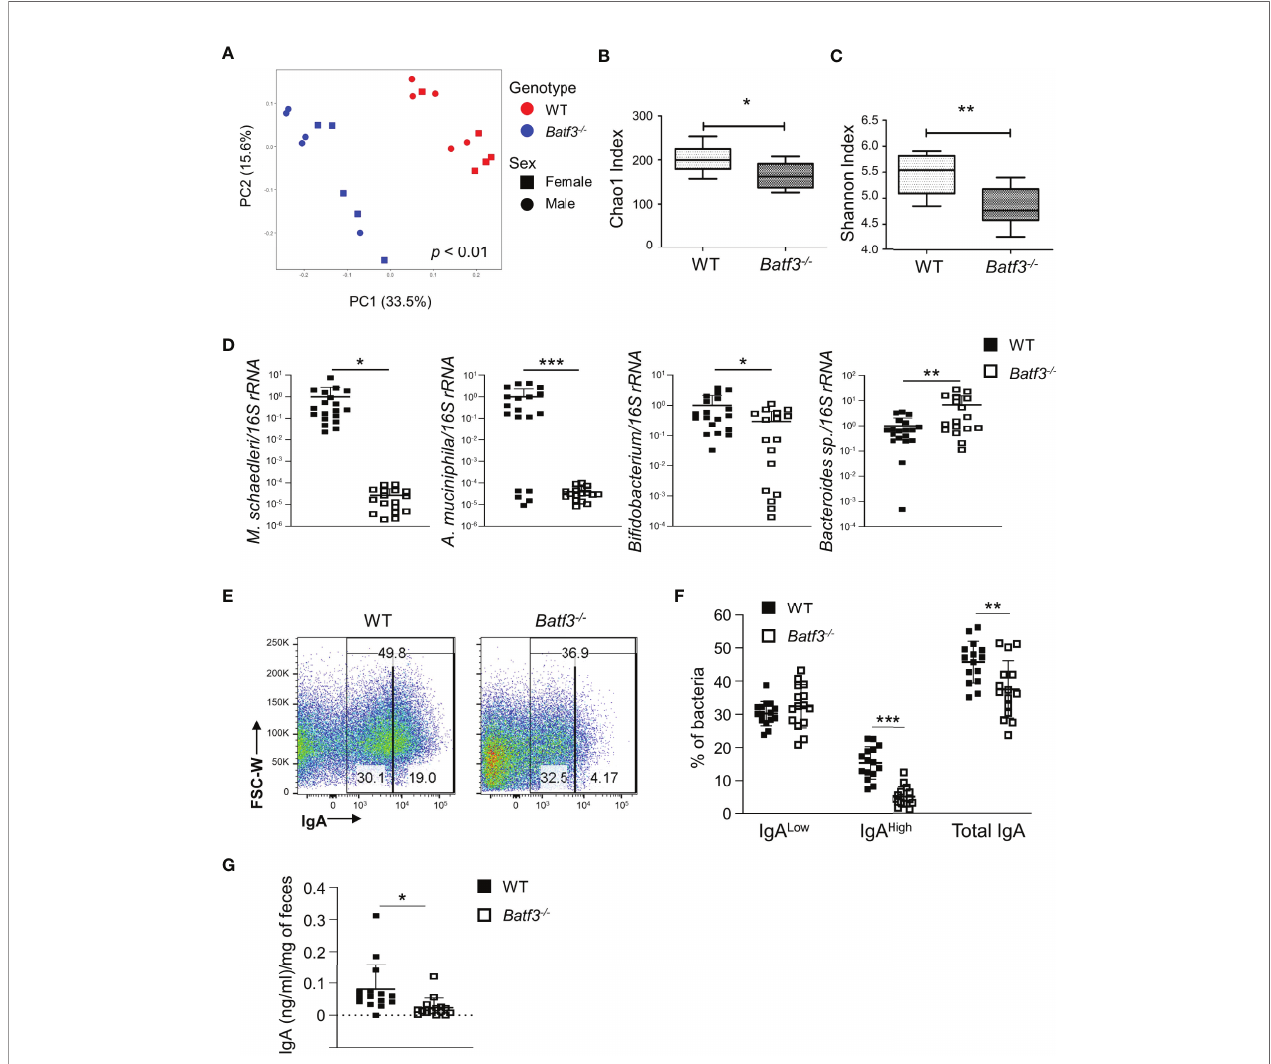
FIGURE 6 | BATF3-de fi ciency leads to intestinal dysbiosis preceding the development of metabolic syndrome. (A) Principal Coordinates Analysis (PCoA) of fecal microbiota of 8-week-old WT and Batf3 -/- mice fed standard chow with consideration for genotype and sex of mice (n = 10/genotype). (B, C) Chao1 index (B) and Shannon index (C) of fecal microbiota of 8-week-old WT and Batf3 -/- mice (n = 10/genotype). (D) Quanti fi cation of relative abundance of Mucispirillum schaedleri, Akkermansia muciniphila, Bi fi dobacterium , Bacteroides sp. in fecal samples of 8-week-old WT and Batf3 -/- mice by qPCR (n = 17-19/genotype). (E) Representative fl ow cytometry plots of IgA coated fecal bacteria isolated from WT and Batf3 -/- mice. (F) Quanti fi cation of IgA low , IgA high and total IgA coated bacteria in feces of WT and Batf3 -/- mice at 8 weeks of age (n =15/genotype). (G) Secreted IgA from fecal samples of WT and Batf3 -/- mice at 8 weeks of age measured by ELISA (n = 15/ genotype). Data are represented as means ± SD (A, D, F, G) or median (bar), interquartile range (box), and range (whisker) (B, C) . Statistical signi fi cance was determined by Adonis test (A) , or Student ’ s t -test (B – D, F, G) . * p < 0.05, ** p < 0.01, *** p <